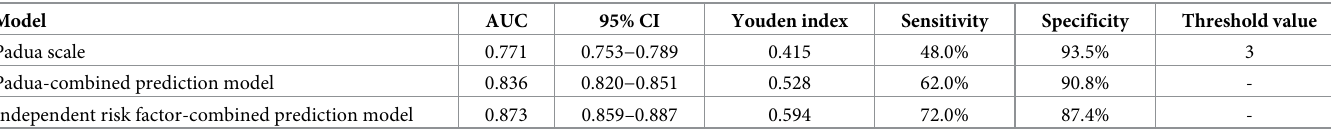
Table 6. Efficacy of the Padua scale, Padua-combined prediction model, and independent risk factor-combined prediction model for predicting risk of VTE.